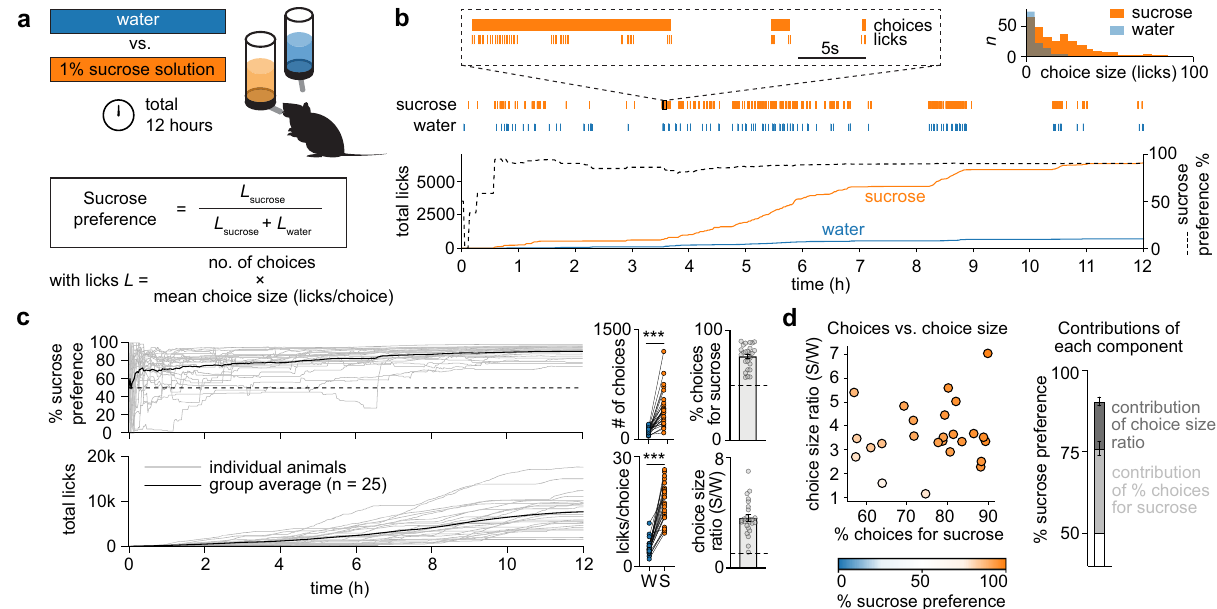
Fig. 1 | A microstructure analysis of licking behavior in the sucrose preference test. a Experimental overview of the sucrose preference test (SPT). A mouse is placed for 12h in an operant chamber that includes a lickometer attached to two bottles that contained either water (blue) or 1% sucrose in water (orange). Sucrose preference was de fi ned as the number of licks for sucrose as a fraction of the total number of licks. b Sample session showing the consumption of sucrose (orange) compared to water (blue).Inset in the upperrightcornershows ahistogram of the numberofchoicesforsucroseandwaterasafunctionofthenumberoflickswithin such choice; choices were separated by a pause in licking of at least 5s. c Left: Sucrosepreferenceandtotallicksovertimefortheentiregroup( n =25mice,male